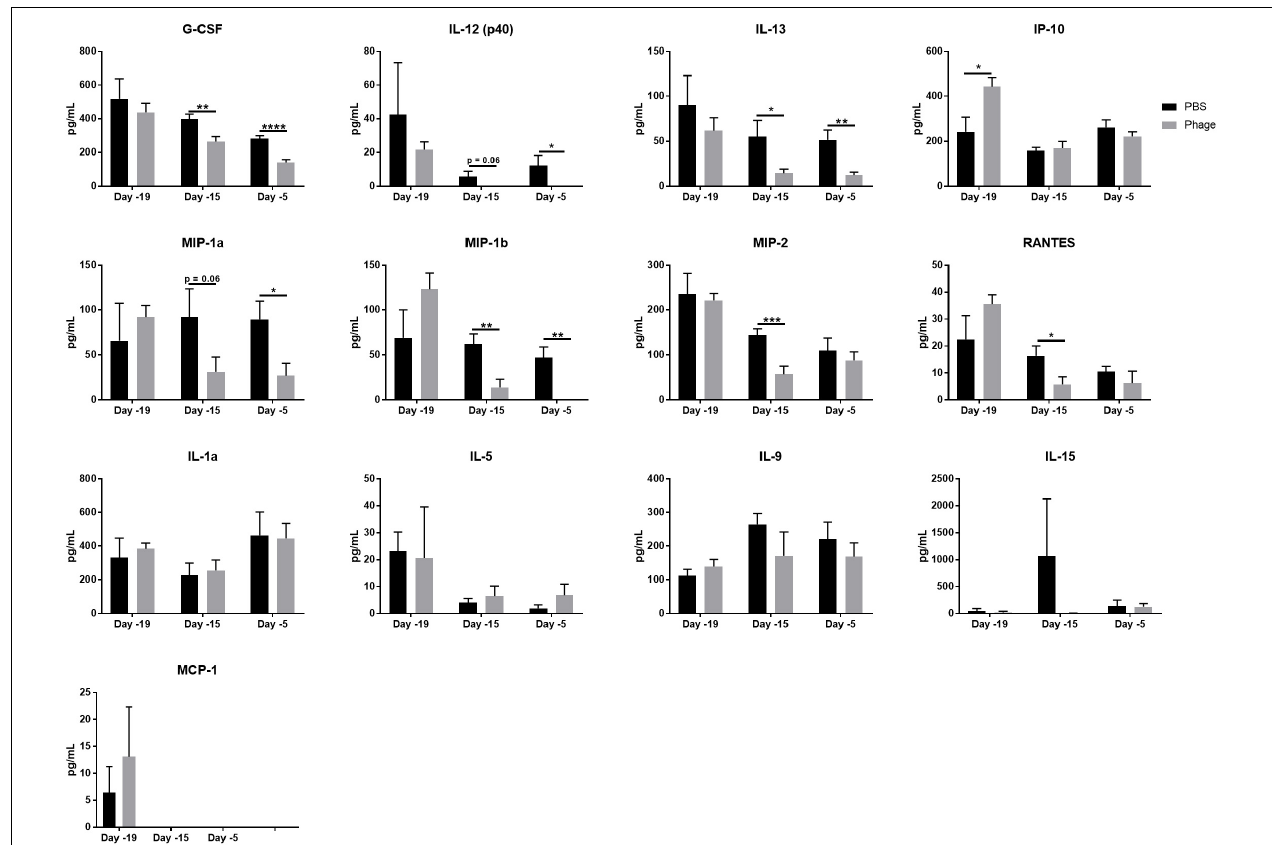
FIGURE 3 | Phage mixture administration decreases monocyte-related cytokines/chemokines in serum. Serum collected from naïve mice given PBS (control) or phage mixture were analyzed for cytokines/chemokines using a 25-plex panel. N = 10 per group for each time point; * p < 0.05, ** p < 0.01, *** p < 0.001, and **** p <